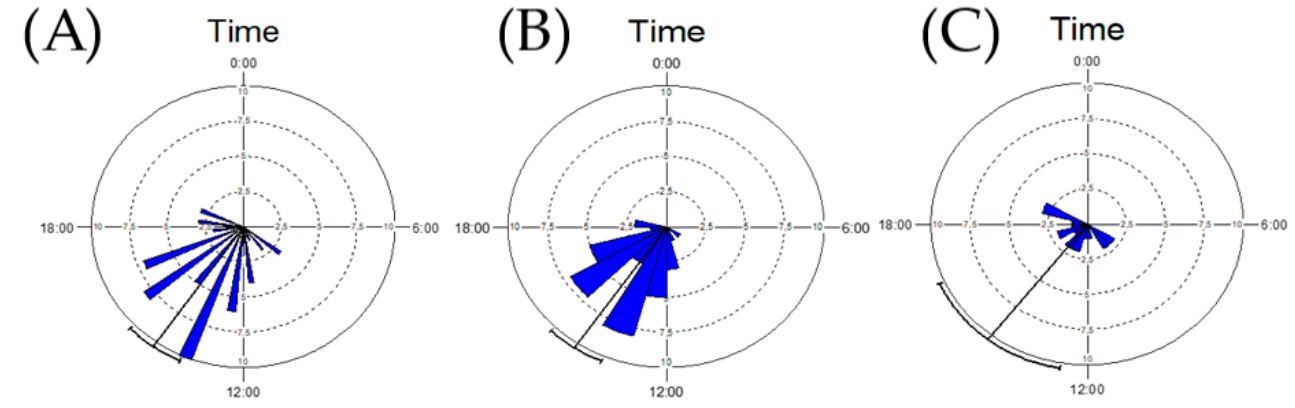
Figure 4. The flight activity by sex: both sexes ( A ), females ( B ), and males ( C ). Peaks of flight activity are indicated with a confidence interval of 95% .